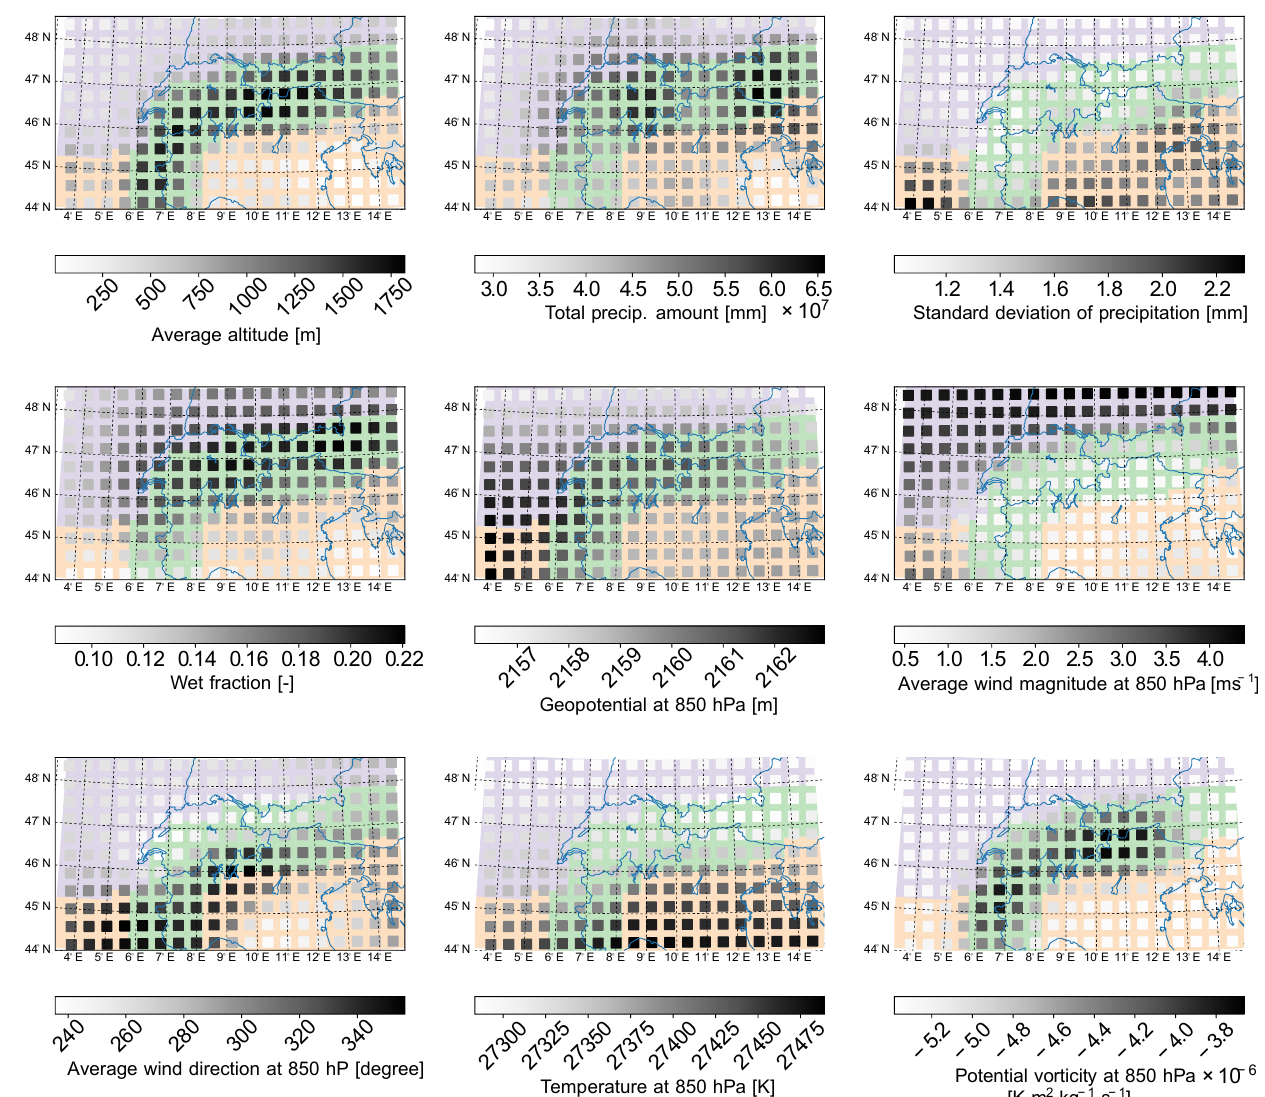
Figure A1. Spatial representation of the location of all areas used in the climatological study of MF parameters and the corresponding local descriptors. Note that the squares are mere indicators of the location of the center of all areas and their size is not to scale with their real sizes. The colors drawn below the squares correspond to the classification obtained in Sect.